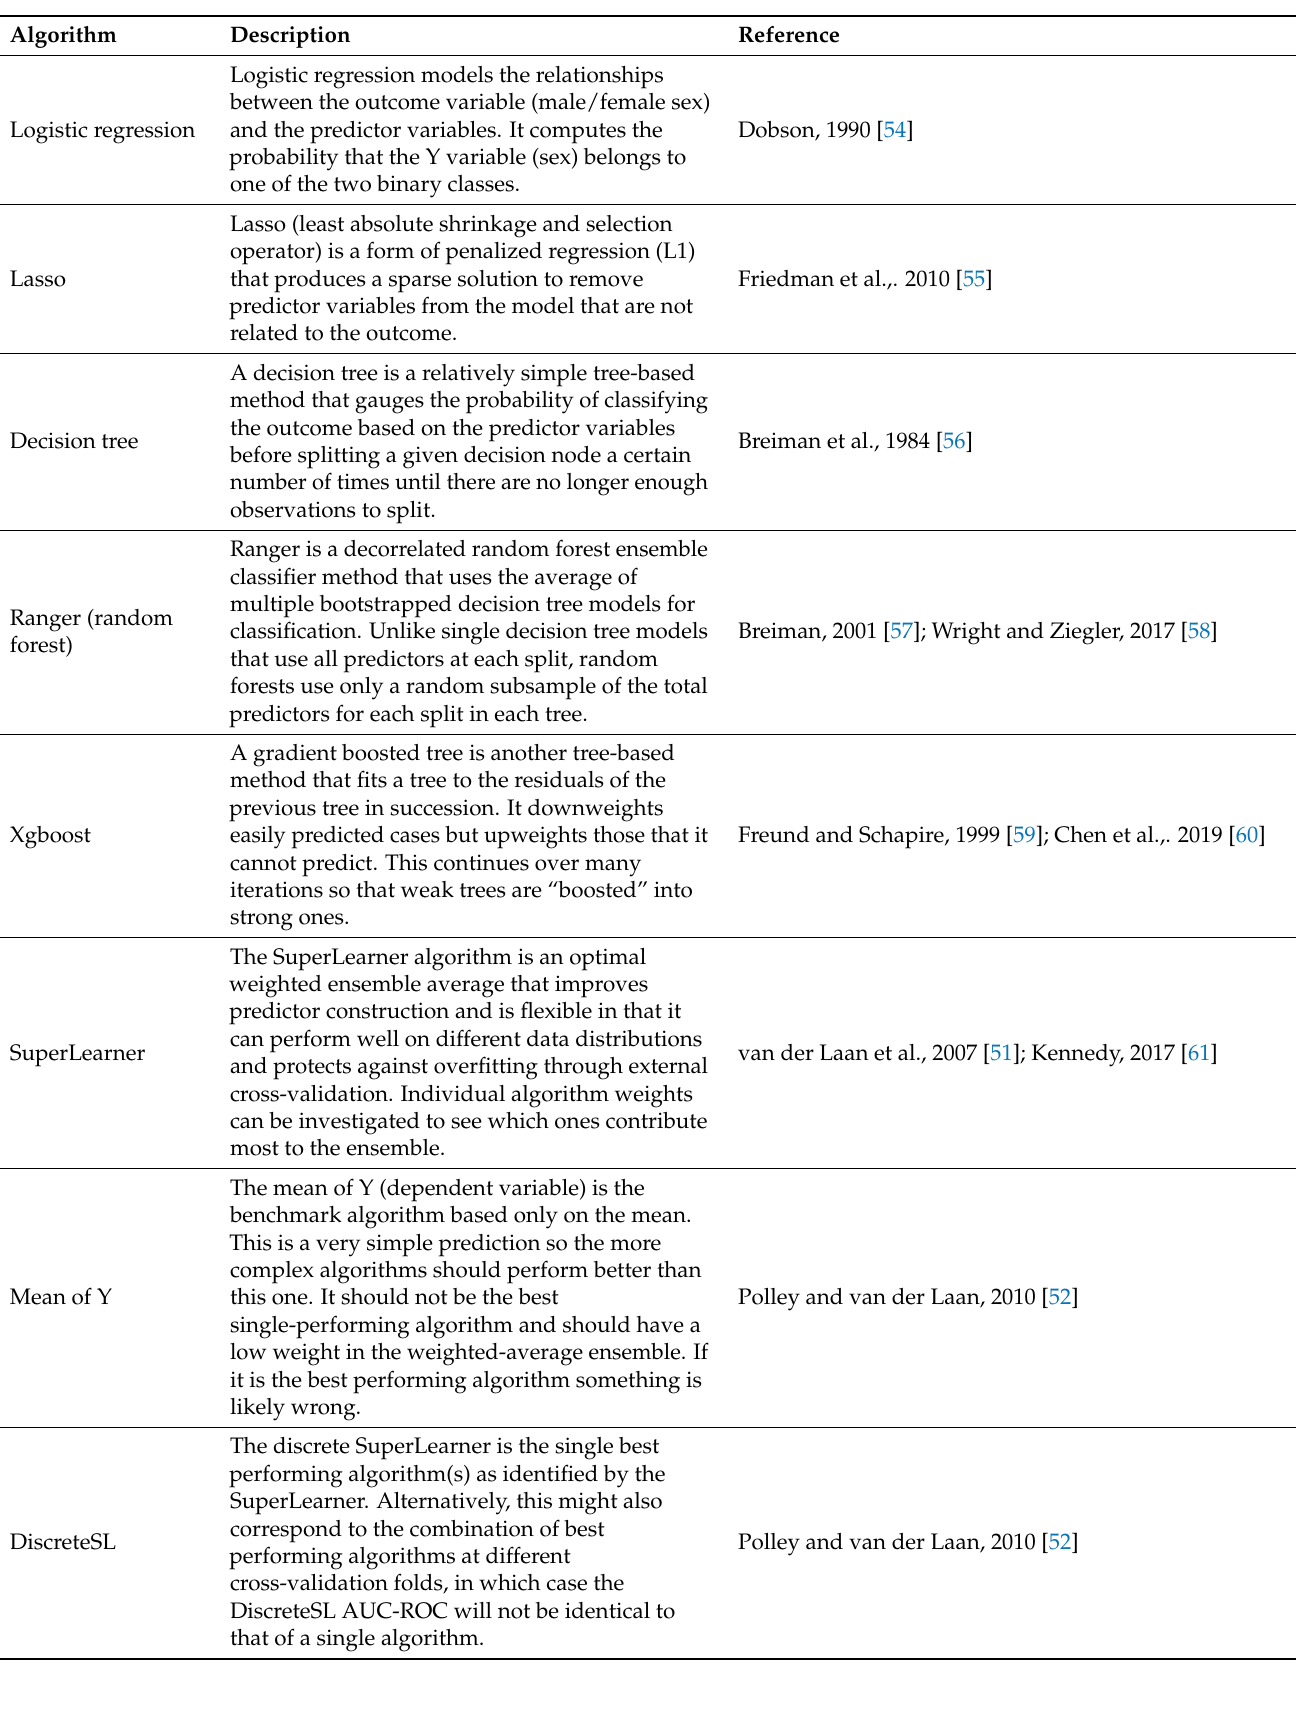
Table 4. Definitions of the eight machine learning algorithms used in this